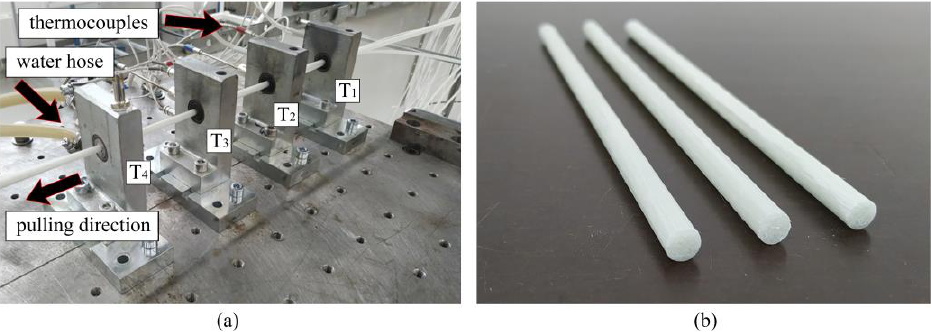
Figure 4. Pultrusion of thermoplastic Ø 6 mm GF/PP bars based on inhouse-made PCTs: ( a ) pultrusion process; ( b ) pultruded bars.